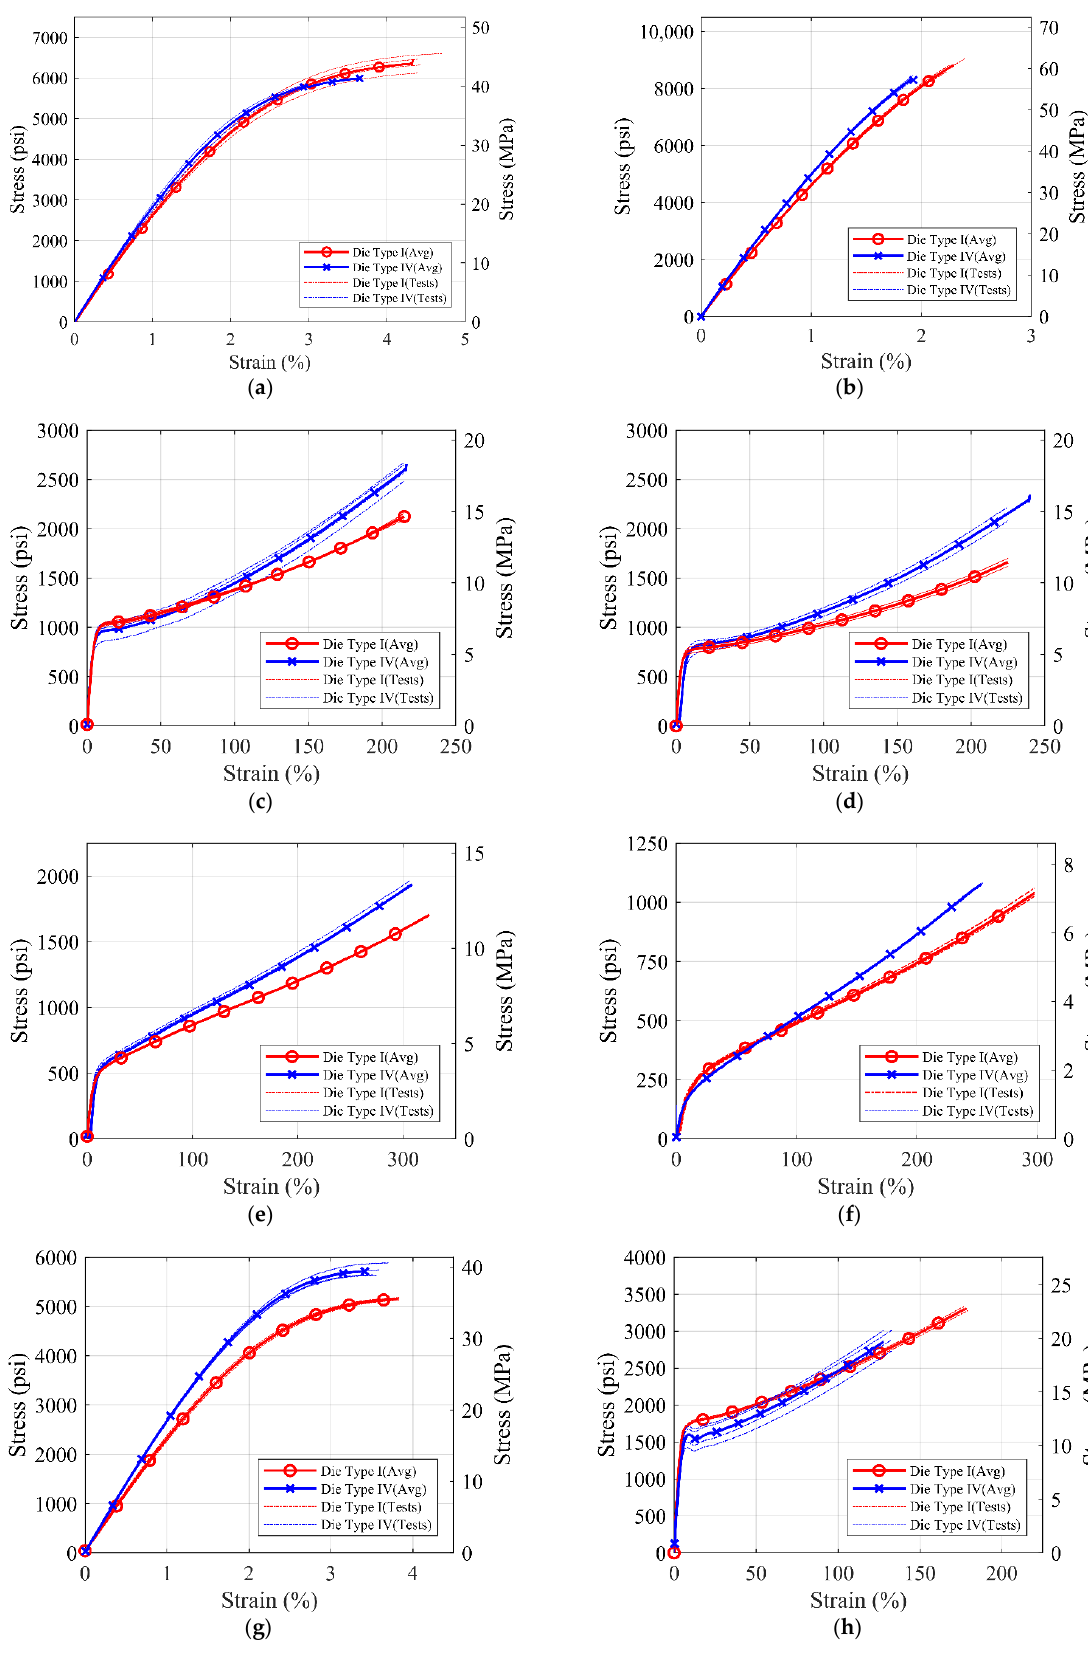
Figure 5. Stress-strain curves for ( a ) S1, ( b ) S2, ( c ) S3, ( d ) S4, ( e ) S5, ( f ) S6, ( g ) S7, and ( h ) S8 material for ASTM D638 Die Type I and Die Type IV coupons for monotonic tensile loading. Table 4 summarizes the yield strength, elongation, and ultimate strength of different polyurea. The yield strength is calculated using the 0.2% strain offset method [38]. The slope of the linear portion of the stress – strain curve is calculated to obtain the initial stiff- ness of the polyurea material. Table 4. Tensile tests results summary for eight different tested commercial polyureas. Polyurea Material ASTM D638 Die Type